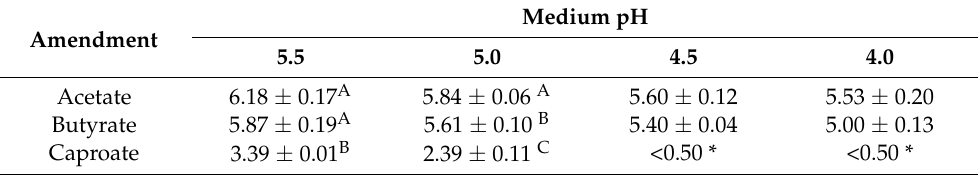
Table 2. Effect of volatile fatty acids on Fol growth.